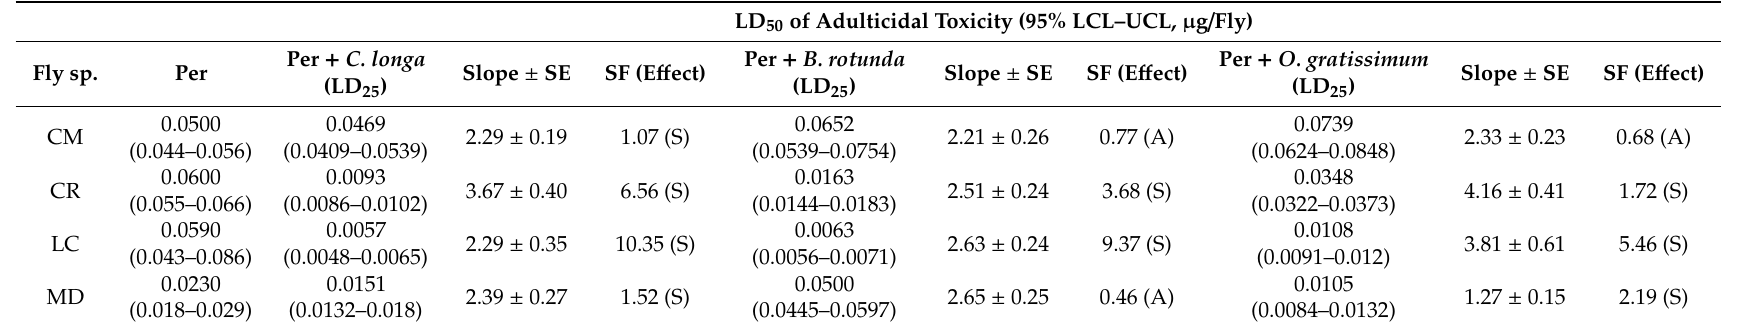
Table 7. Adulticidal toxicity of permethrin combined with three EOs against the blow flies and the house fly. LD 50 of Adulticidal Toxicity (95% LCL–UCL, µ g / Fly)